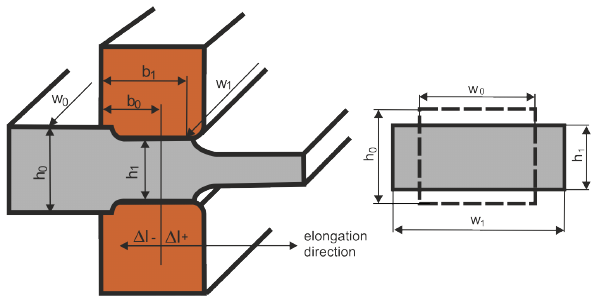
Figure 2: The geometry of the forging during the elongation forging process: initial parameters: height h 0 , width w 0, length l 0 , and bite length b 0 ; parameters for a single draft: height h 1 , width w 1 , length l 1 , and bite length b